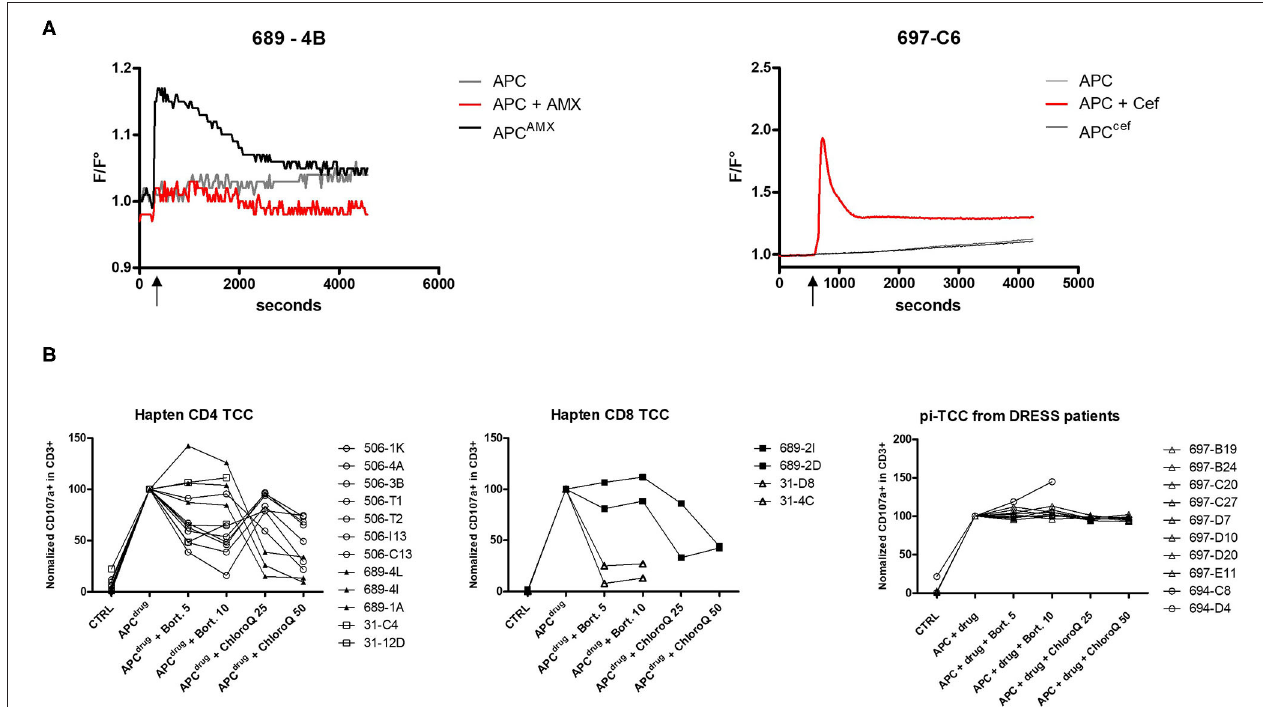
FIGURE 3 | Comparison of hapten and p–i features of TCC reacting to β -lactams. (A) Intracellular calcium concentration (represented by F/F 0 ratio) in TCC was measured by fluorescence. After 5min (600s) of baseline measurement, β -lactam-pulsed EBV-BLCL and EBV-BLCL together with drug in solution was separately added. The increase of calcium concentration was monitored for 60min. The left plot shows an example of a TCC reacting according to the hapten mechanism (patient 689 suffering from MPE) and the right plot shows an example of a TCC reacting to ceftriaxone according to p–i from a patient of DRESS (697). (B) The involvement of the antigen processing machinery has been investigated by adding bortezomib and chloroquine during APC pulsing and TCC stimulation. TCC activation was measured by CD107a upregulation with flow cytometry and TCC activation with pulsed APC (APC drug ) was normalized to 100%. Measurements were repeated at least